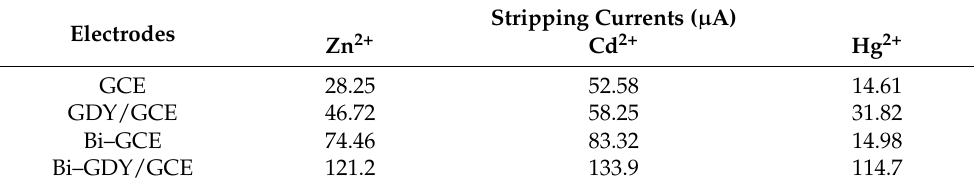
Figure 6. The effect of ( A ) different volumes of 1.0 mg/mL GDY suspension, ( B ) the types of 0.1 M supporting electrolytes (HAc − NaAc, Tris − HCl, BR), ( C ) pH of HAc − NaAc, ( D ) the concentration of